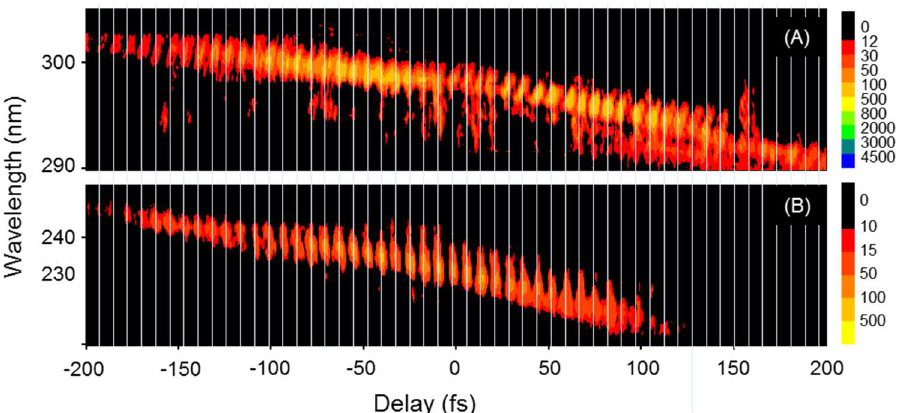
Figure 9. Expanded views of the FROG trace in ( A ) Stokes ( B ) anti-Stokes regions shown in Figure 3A. The interference fringe patterns are more clearly seen by expansion of the picture. A sapphire plate (0.1 mm) was used as the SD material. White lines are drawn to indicate a spacing of 8 fs. A periodic structure suggests a sufficient stability of the relative phases of the Raman sidebands. Note that the total number of fringes in the trace is much larger than the value predicted from calculations (see Figure 6), which can be attributed to the pulse width (ca. 170 fs) being expanded by the optics, such as the dichroic mirrors, and also by the air in the beam path of the Raman emissions. In order to generate a single optical pulse, it would be necessary to expand the spectral domain for the probe beam, e.g., the use of a <8-fs pulse with a negative chirp for pulse compression by the optical components and the air in the beam path. This approach would be applied for generating sub- femtosecond, or even attosecond pulses, with energy higher than 10 eV (<120 nm). Since it is difficult to generate a negatively-chirped pulse in the DUV region (e.g., no such chirp mirror is available), a positively-chirped probe pulse was prepared by passing the beam through the SiO 2 plate, and the effect of chirping on the generation of Raman sidebands was examined. When the pulse width was increased to 50–220 fs, the efficiency for the generation of Raman sidebands was decreased by 25%, some (or most) of which can be attributed to a slight beam walk-off in the alignment of the laser beam. Thus, this type of approach using a (negatively) chirp pulse would be useful for pulse compression in the DUV region. It should be noted that the electric field of the optical pulse can be controlled by changing the carrier envelope phase of the fundamental laser, thus providing optimal performance in the applications such as high-order harmonic generation.